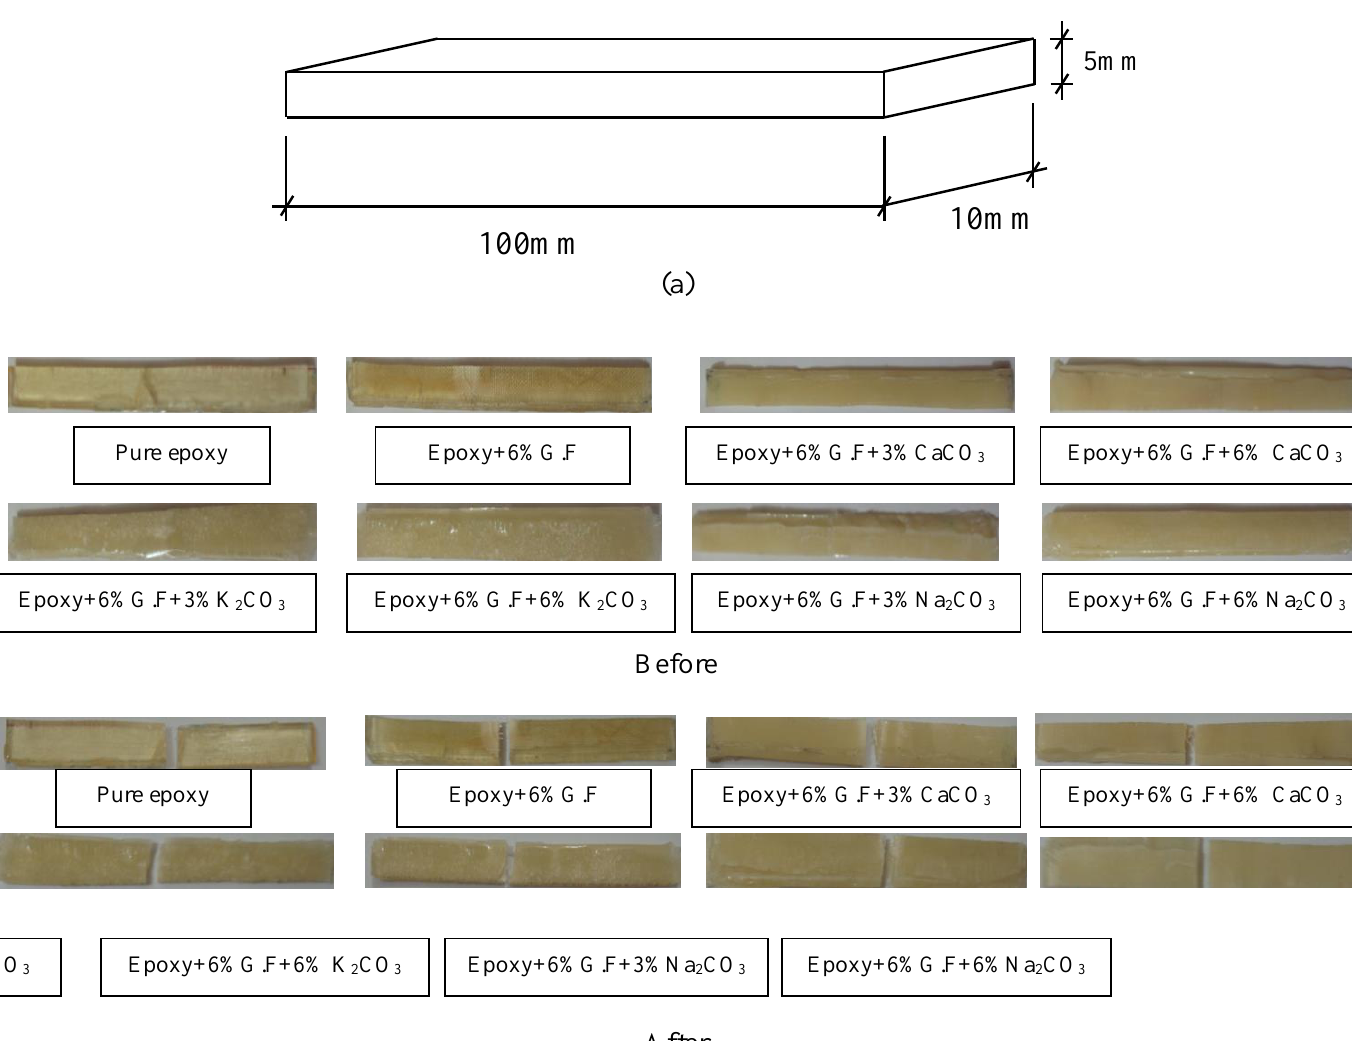
Fig.5: (a) Flexural strength standard specimen [26], (b) Experimental specimens before & after